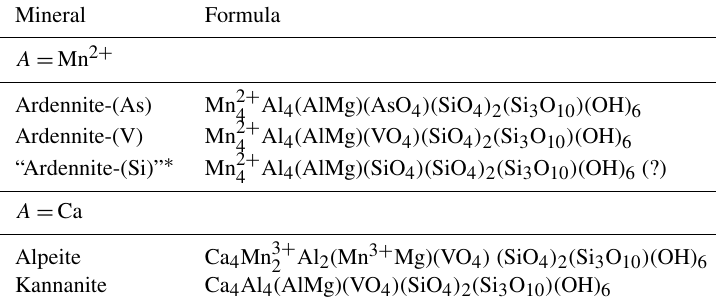
Table 5. End-member formulae of the ardennite-group minerals.